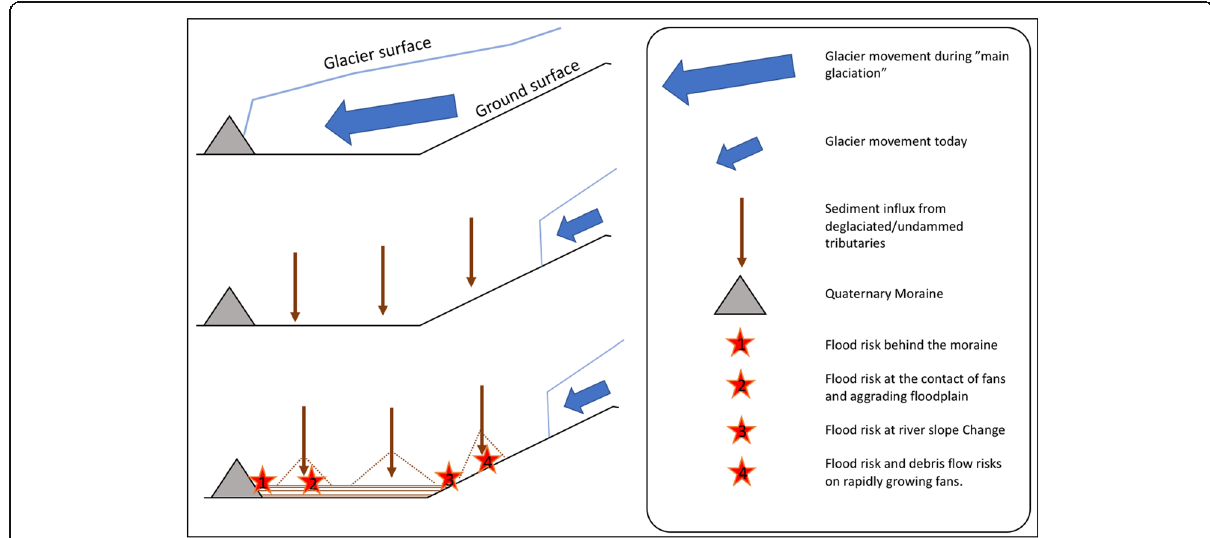
Fig. 2 Conceptual idea of the interplay between different sediment generations during the